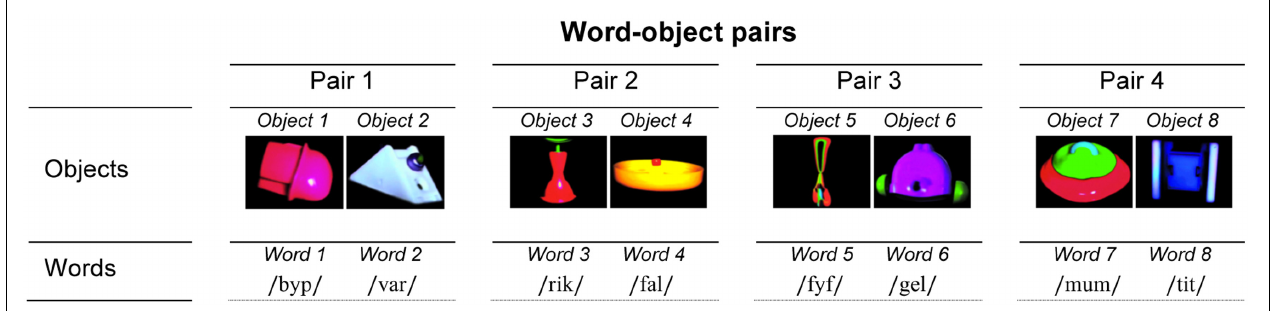
FIGURE 1 | The four word-object pairs used. The word-object association is counterbalanced across participants.